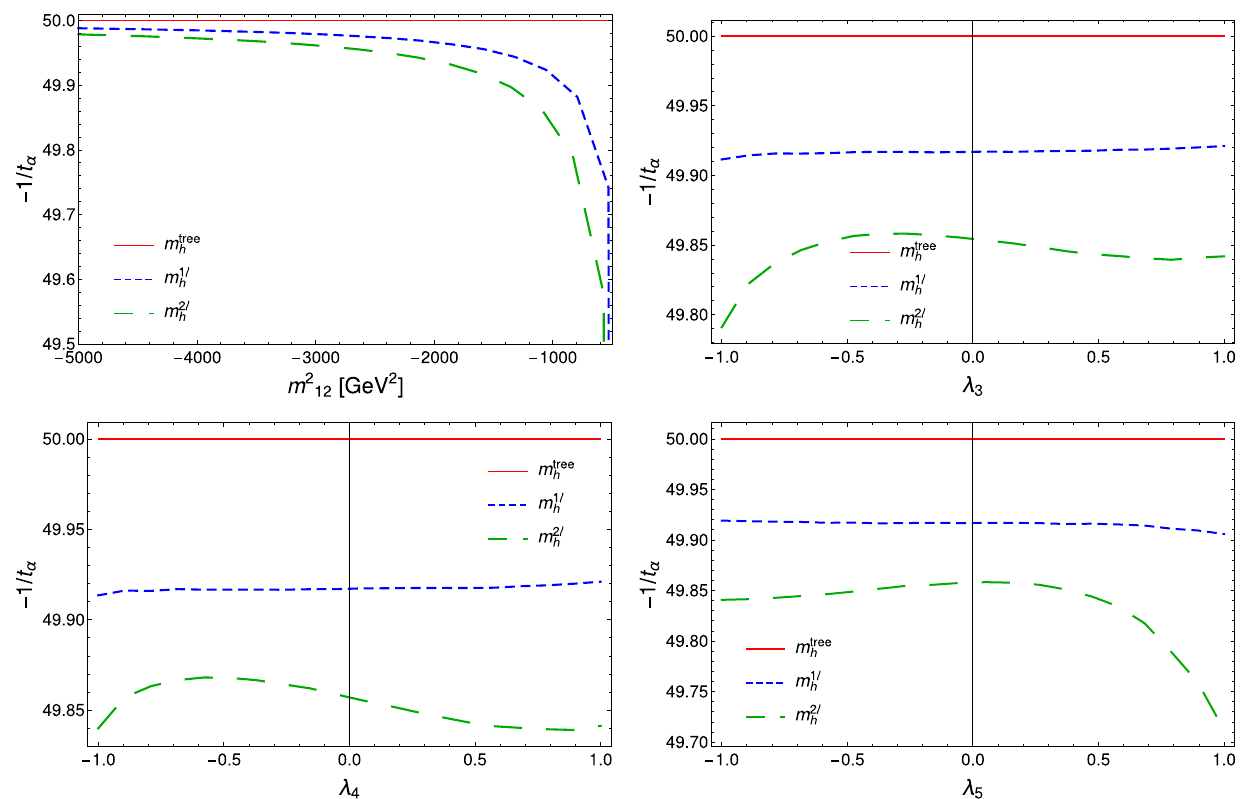
Fig. 7 − 1 / t α as a function of the off-diagonal mass term m 2 left), and of quartic couplings λ 3 (upper right), λ 4 (lower left) and λ 5 (lower right) at each order in perturbation theory. For each plot we vary the parameters as follows: we choose one parameter as the abscissa; the tree-level alignment condition λ 1 = λ 2 = 1 / 2 λ 345 plus the requirement that the Higgs mass is 125 . 09 GeV fixes three param-